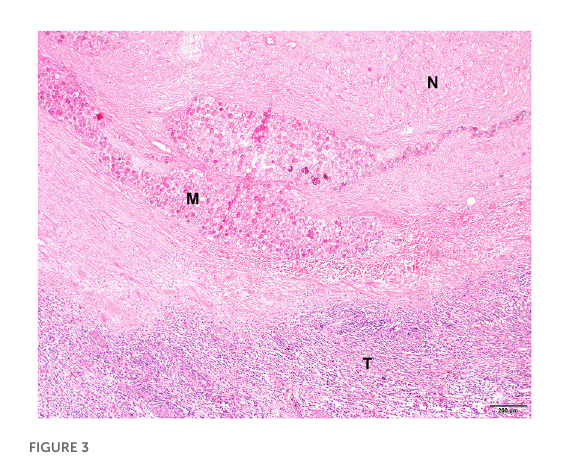
FIGURE3 Histopathological picture of a spindle cell sarcoma of patient 3, 36 days after holmium-166 microspheres injection. Extensive necrosis is visible in the upper part of the image (N) with several foci containing microspheres (M). The bottom part of the image shows remaining neoplastic tissue with moderate lymphoplasmacytic inflammation (T). Hematoxylin and eosin